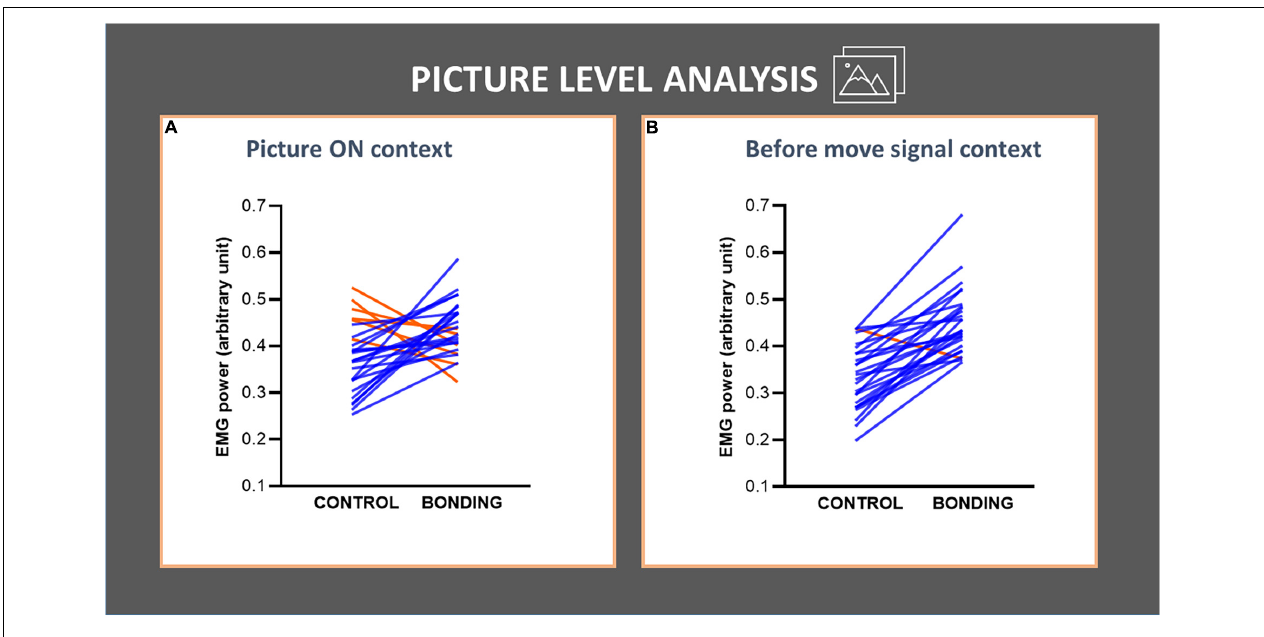
FIGURE 3 | Picture-level analysis in each context (A,B) of the finger flexor muscle EMG activity. The lines joining control and bonding conditions represent normalized EMG power for each of the 26 dyads, averaged from all participants, i.e., each line represents a pair of control and its respective bonding picture. Blue lines represent data for dyads with increased values in bonding relative to the control conditions and red lines represent the opposite. (A) Picture ON context: observe that 20 out of 26 pairs showed an increase in EMG activity for the bonding condition relative to the matched control. (B) Before move signal context: observe that 25 out of 26 pairs showed an increase in EMG activity for the bonding condition relative to the matched control.